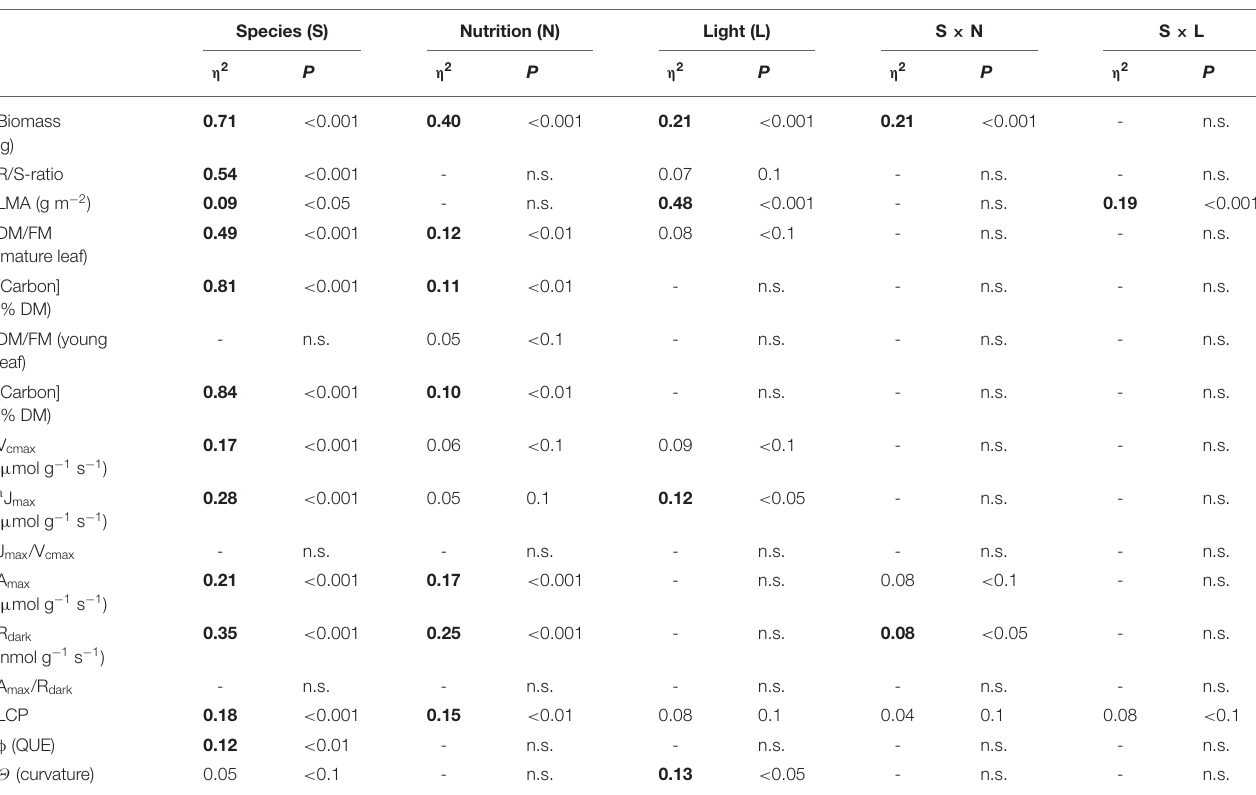
TABLE 2 | Results of analysis of variance